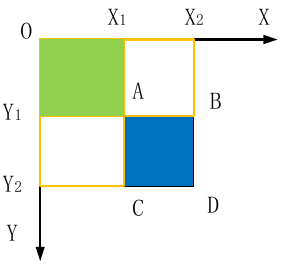
Figure 7. Schematic diagram of rectangular pixels and calculation.